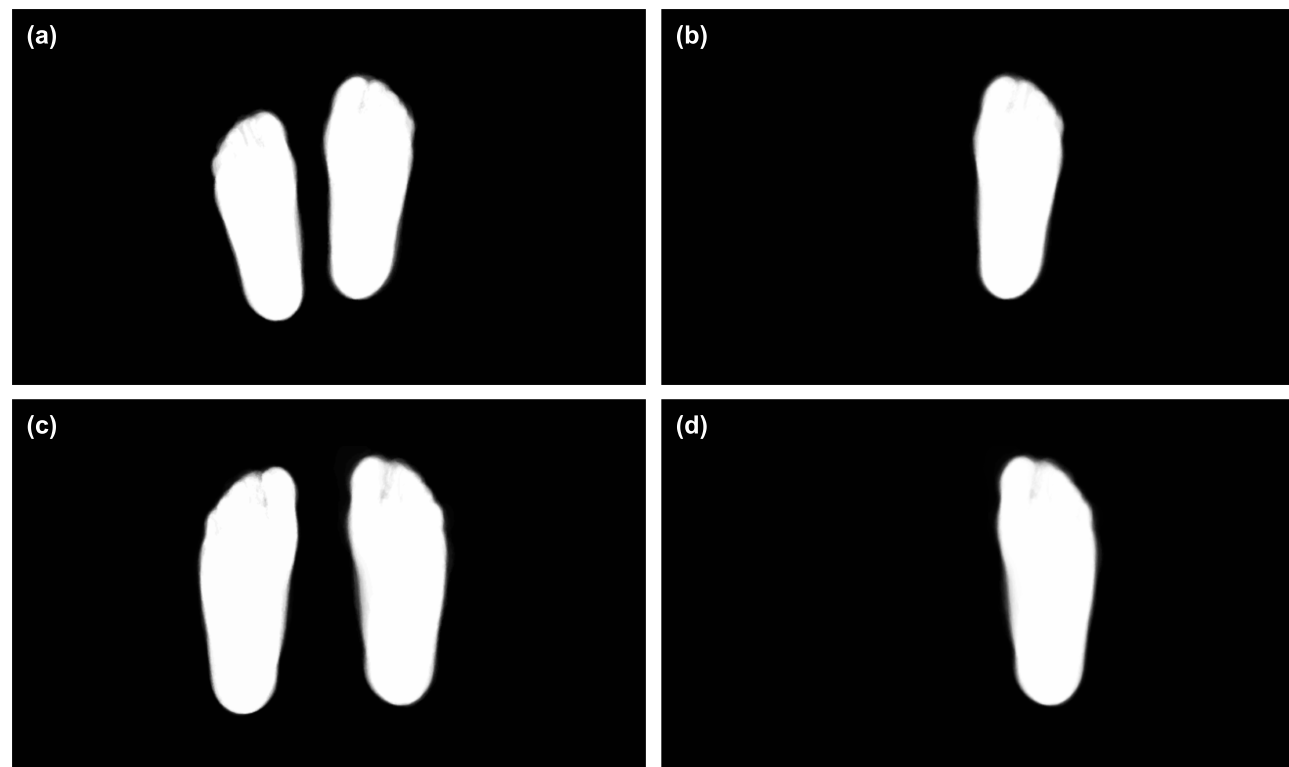
Figure 6. IR images for all the subjects were registered to the respective models: ( a ) female and ( c ) male. The images corresponding to the right foot were flipped and registered to the left foot for both groups of subjects: ( b ) female and ( d )